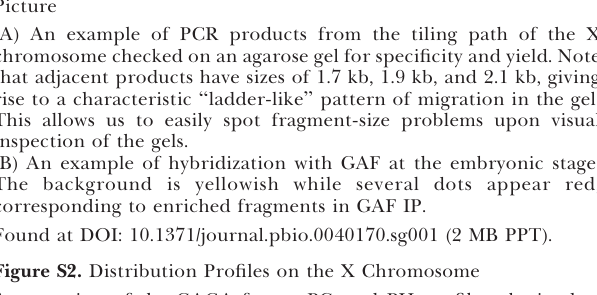
Figure S1. PCR Quality on Agarose Gels and Example of Microarray Picture (A) An example of PCR products from the tiling path of the X chromosome checked on an agarose gel for specificity and yield. Note that adjacent products have sizes of 1.7 kb, 1.9 kb, and 2.1 kb, giving rise to a characteristic ‘‘ ladder-like ’’ pattern of migration in the gel. This allows us to easily spot fragment-size problems upon visual inspection of the gels. (B) An example of hybridization with GAF at the embryonic stage. The background is yellowish while several dots appear red, corresponding to enriched fragments in GAF IP. Figure S2. Distribution Profiles on the X Chromosome An overview of the GAGA factor, PC, and PH profiles obtained at four developmental stages (embryos, pupae, adult males, and adult females) on the X chromosome tiling path. The profiles represent an average of the normalized FC in two to three independent experi- ments for each protein. Figure S3. Embryonic Distribution Profiles on the X Chromosome and the 2L Chromosome These graphs refer to Figure 2 but show only the significant binding sites as detected by RDAM at FDR 10%. The X chromosome is on the left and Chromosome 2L is on the right. Indicated above is the cytology of each chromosome. Figure S4. Distances between PcG Target Fragments and Gene Promoters Blue shows the distribution of distances (in kb) between PcG binding sites and the closest gene promoter. (cid:3) means upstream and þ means downstream relative to the promoter. 28.9% of the detected PcG binding sites are located less than 2 kb upstream from the 5 9 end